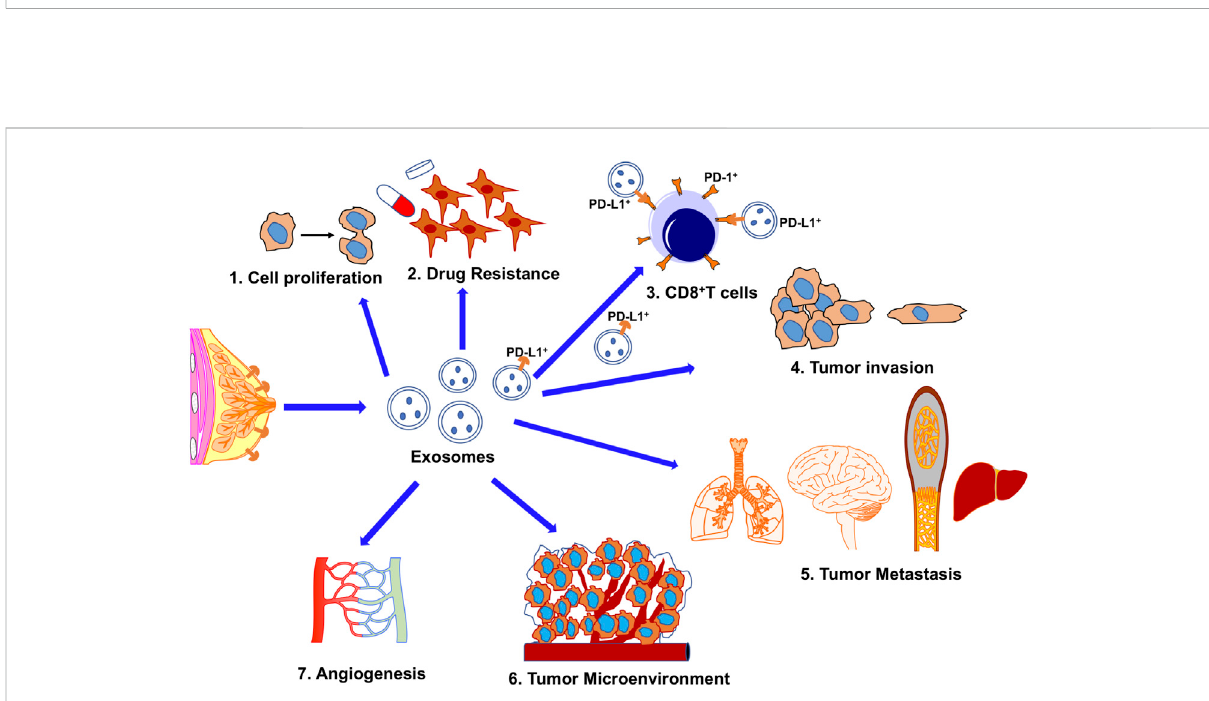
FIGURE 2 The potential roles of exosomes in TNBC biology and treatment stratagies. 1. Enhance tumor cell proliferation; 2. Increase drug resistance; 3. Immune-escape; PD-L1+ exosomes secreted from cancer cells confer acquired resistance to immunotherapy mediated by the direct binding between exosomal PD-L1 and T cells or between exosomes and α -PD-L1 monoclonal antibodies. 4. Stimulated tumor progression; 5. Metastasis; 6. Exosomes derived from cancer cells transfer contents to the tumor microenvironment; 7. Enhanced